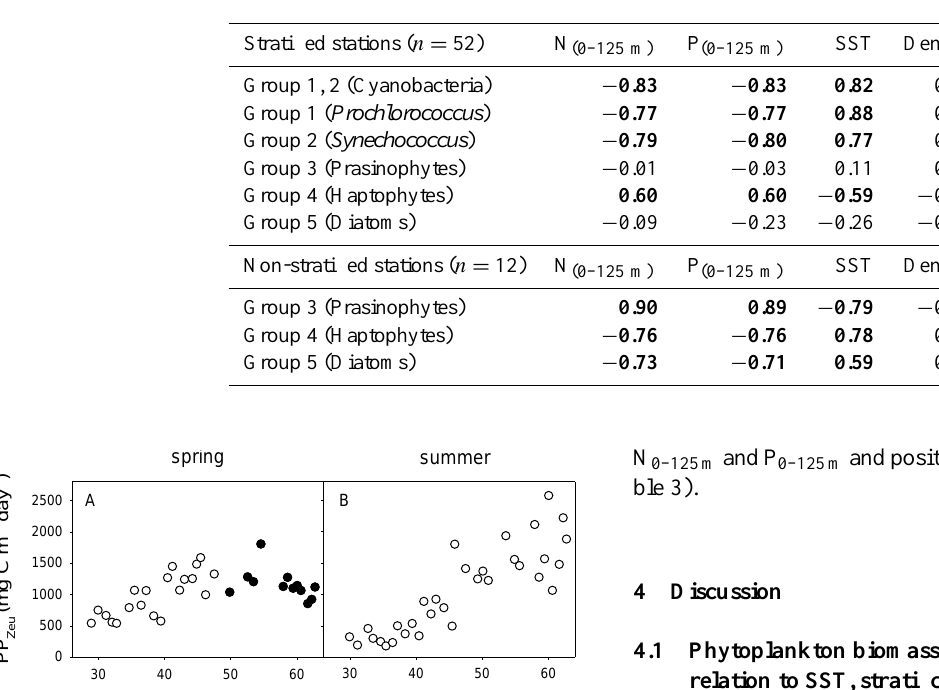
Table 3. Spearman rank-order correlation coefficients of estimated contribution to primary production of group 1 ( Prochlorococcus ), group 2 ( Synechococcus ), group 1 and 2 combined (cyanobacteria), group 3 (prasinophytes, cryptophytes and pelagophytes), group 4 (haptophytes and dinophytes), and group 5 (diatoms) between nitrate (N 0–125m ) and inorganic phosphate (P 0–125m ) concentrations in the potential eu- photic zone, sea surface temperature (SST), and density differences in the upper 200m (density). Data are shown for stratified ( n = 52) and non-stratified ( n = 12) stations from spring and summer cruises.